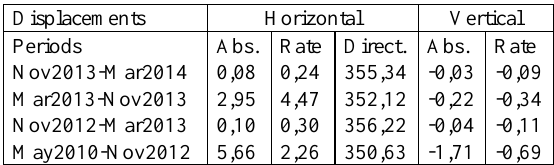
Table 2. Average displacements of relevant points between observation campaigns.